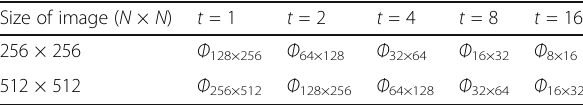
Table 2 Different dimensional measurement matrices Φ ( t ) for images ( M / N =